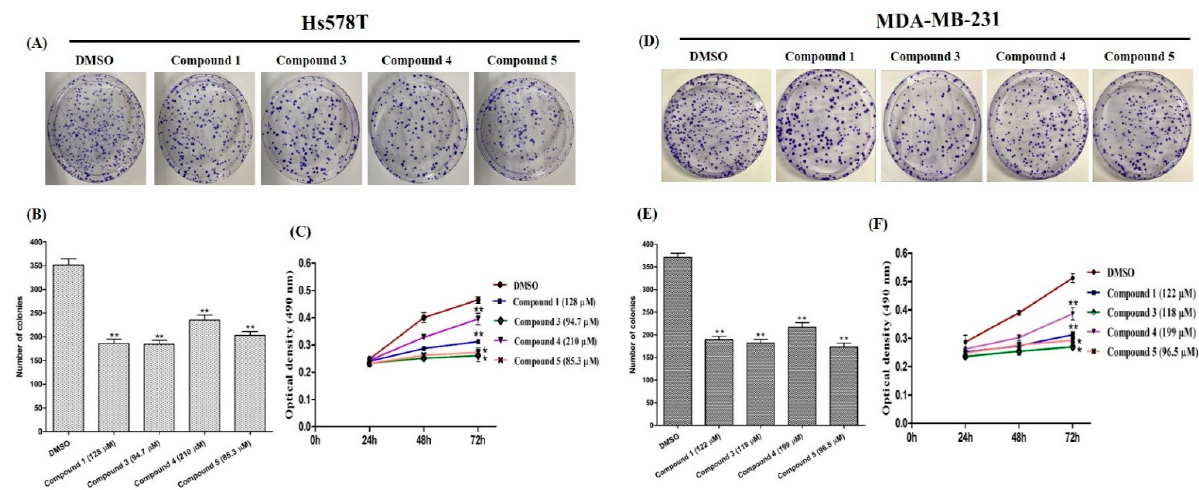
Figure 3. Inhibition of TNBC cell proliferation. ( A ) and ( D ): visualized colonies after two weeks of treatment of TNBC cells with tested compounds. ( B ) and ( E ): quantified colonies from colony formation assay. ( C) and ( F ): the amount of viable cells after treatment of the cells with compounds for 24, 48, and 72 h, determined using an MTS assay. Data are presented as the mean ± SD of three independent experiments. Bars and lines with asterisks indicate significant differences from the control at p ≤ 0.05 (*) or p ≤ 0.01 (**).